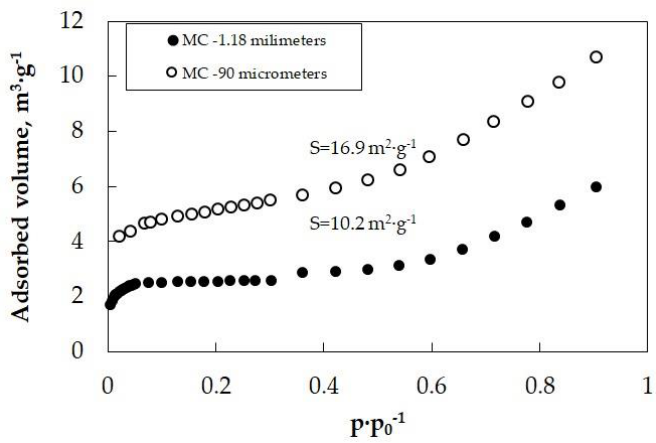
Figure 4. Nitrogen adsorption isotherm of the MC sample.